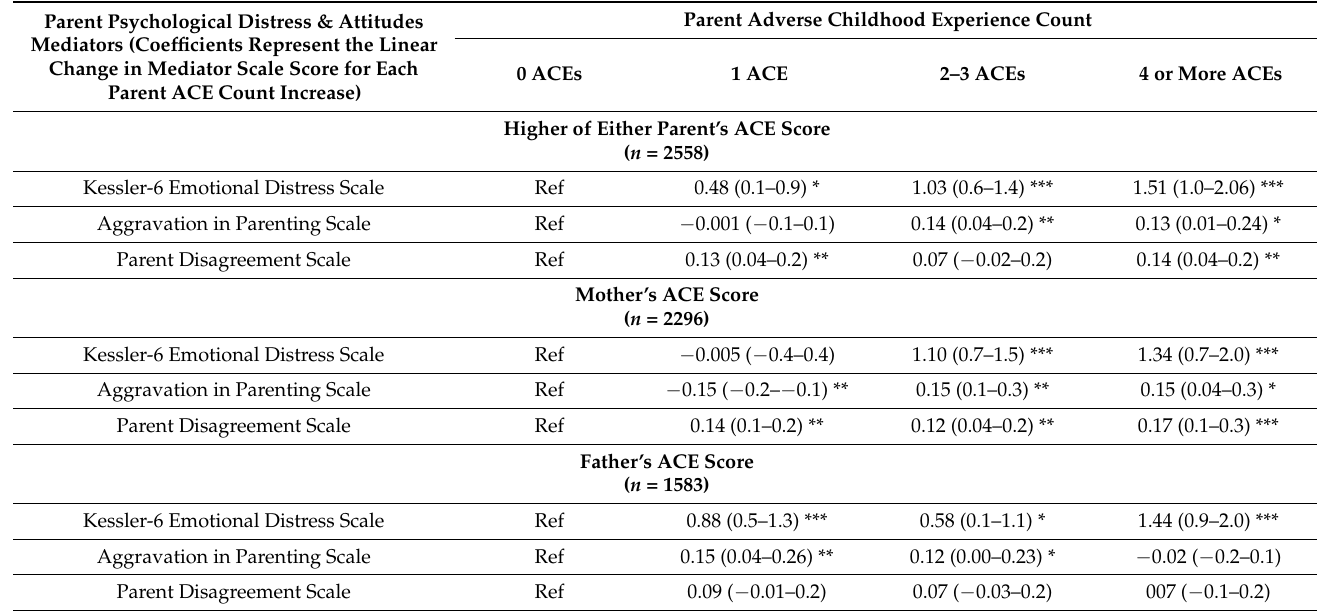
Table 4. Associations between Parents’ Adverse Childhood Experiences Reported in the Childhood Retrospective Circum- stances Survey and Mediator Measures from the Same Parents Reported in the 2014 Child Development Supplement. Parent Psychological Distress & Attitudes Mediators (Coefficients Represent the Linear Change in Mediator Scale Score for Each Parent ACE Count